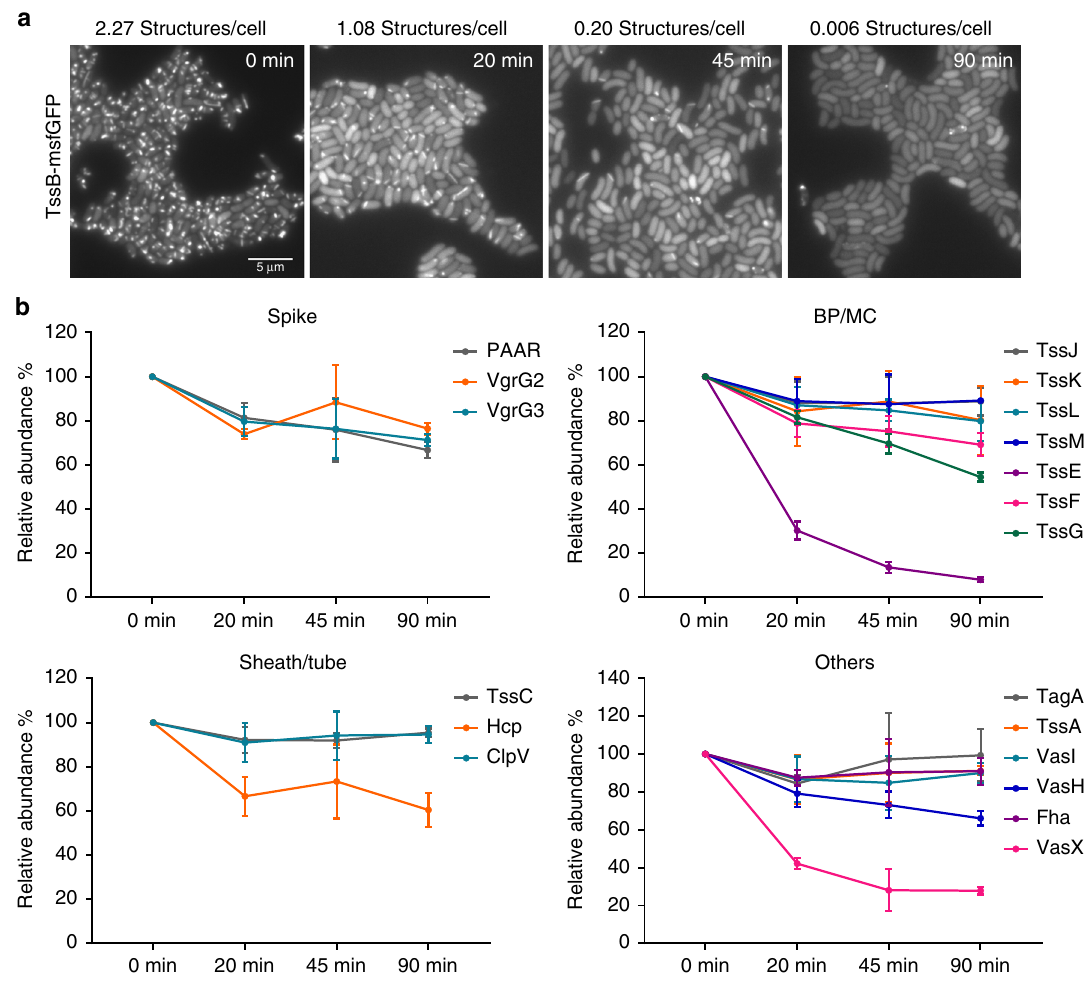
Fig. 4 Change in abundance of V . cholerae T6SS proteins upon chloramphenicol treatment. a The sheath assembly was monitored by TssB-msfGFP localization after 1 mg/ml of CAM treatment. Representative images of GFP channel are shown. Time-lapse movies with a larger fi eld of view can be found in Supplementary Movie 2. The average number of sheaths is indicated above the images. Scale bar: 5 µ m. b The relative abundance levels of each component at four time points following the CAM treatment (0, 20, 45, and 90 min, respectively). Note the y ‐ axis is shown as % abundance normalized to TssB related to the protein levels at T0 (0 min; pre-treatment). The error bar represents the standard deviation of measurements ( n = 3 biologically independent samples). Plots were grouped into four subsets: spike proteins, baseplate/membrane complex, sheath/tube proteins, and other components. Individual plots are shown in Supplementary Fig. 3. The detailed quanti fi cation for this fi gure can be found in Supplementary Data 3. Source data